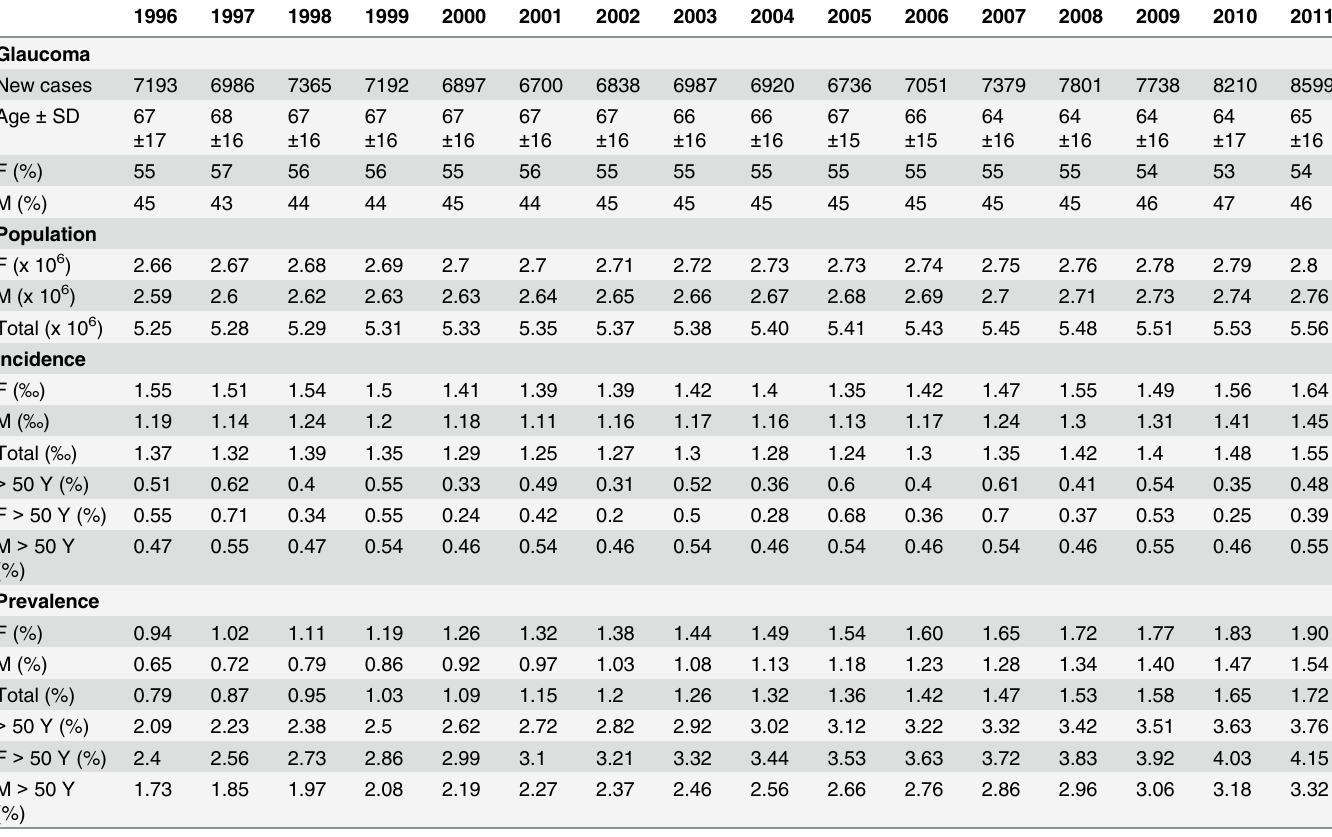
Table 1. Baseline characteristics of 116,592 glaucoma patients in the Danish population in the period from 1996 to 2011. The total Danish popula- tion, incidence and prevalence are calculated for each